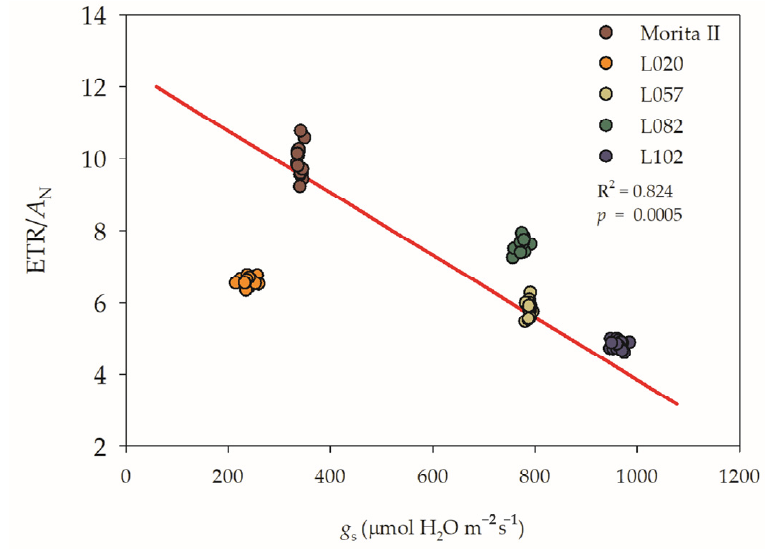
Figure 3. Regression between the ratio of electron transport rate (ETR) and net photosynthesis ( A N ) versus stomatal conductance ( g s ) evaluated in five genotypes of Stevia rebaudiana (Morita II, L020, L057, L082, and L102) under land conditions in the complete absence of any plant stress. The regression R 2 and p value are shown.